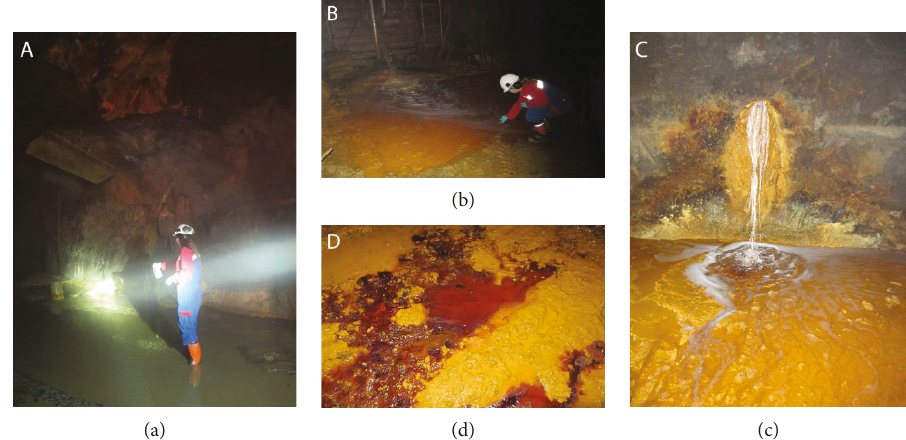
Figure 1: Collecting water samples in the Pyhäsalmi mine. (a) Collection of mine water dripping from the roof at the depth of 240m belowground (sample P240m), (b) collection of water sample from the pond at depth 500 m belowground (sample P500m), and (c-d) sampling point at depth 600 m belowground (sample